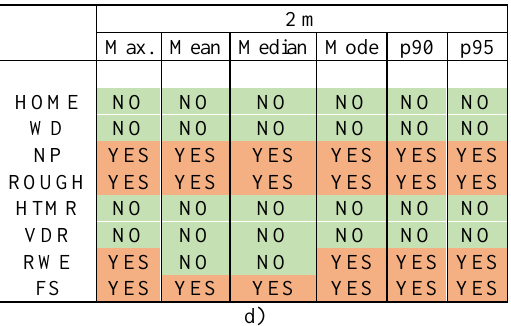
Table 2. Statistical test results for each testing set: ( a ) 0.25 m, ( b ) 0.5 m, ( c ) 1 m, and ( d ) 2 m. “YES” and red-coloured cells indicate that there was a significant difference at 95% of confidence level, whereas “NO” and green-coloured cells means that there was not a significant